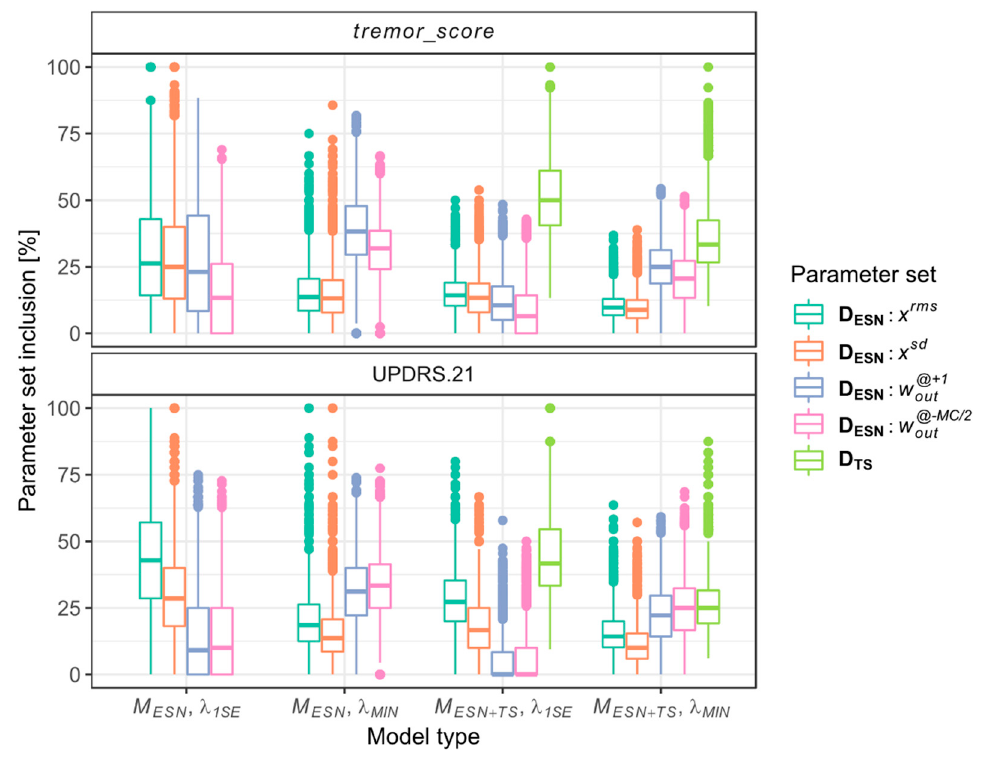
Figure 5. Inclusion of parameters from D TS and D ESN sets in individual M ESN and M ESN + TS models (as a percentage of model parameters). Results are grouped according to the model type and λ LASSO regularization parameter.